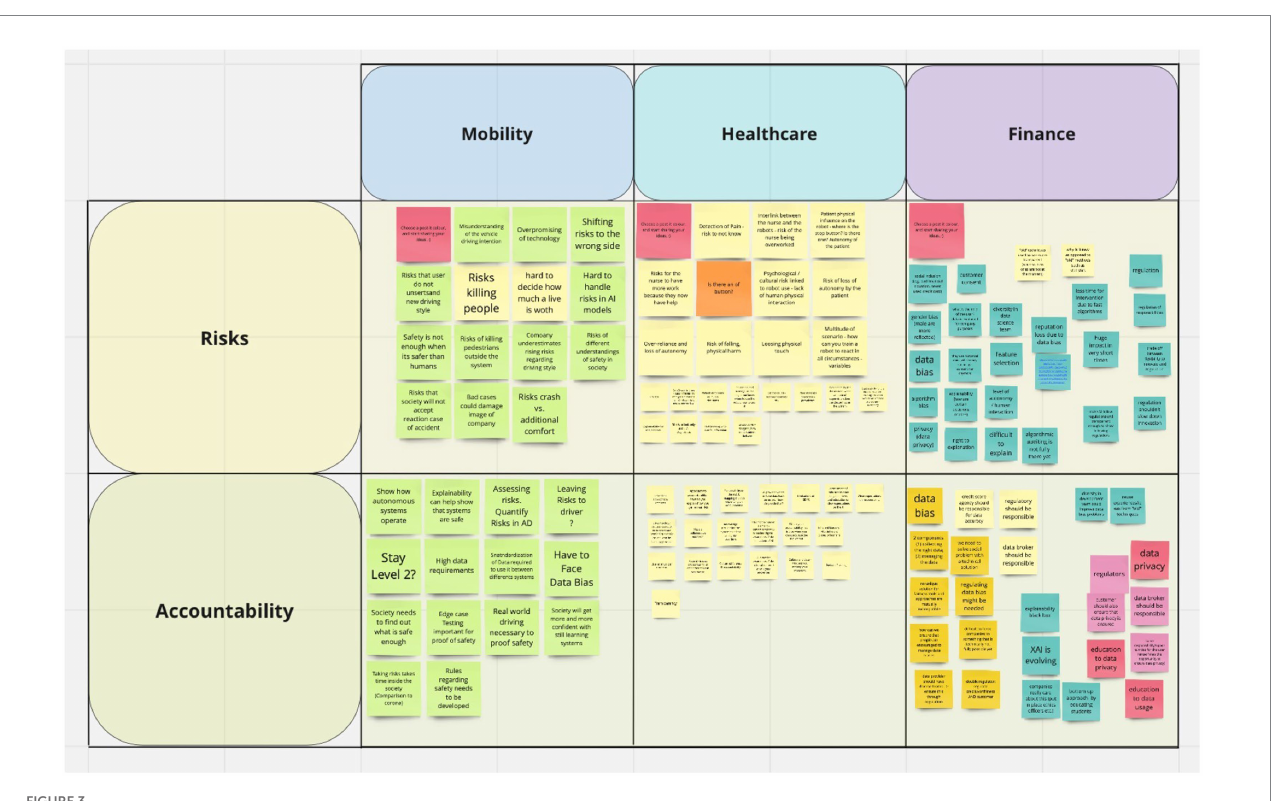
FIGURE 3 Screenshot of online collaborative “Miro-board” used for the use case